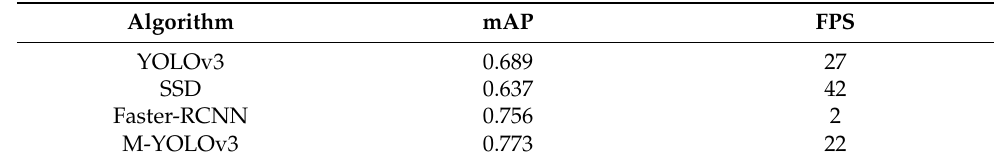
Table 2. Comparison of improved YOLOv3 with other target detection